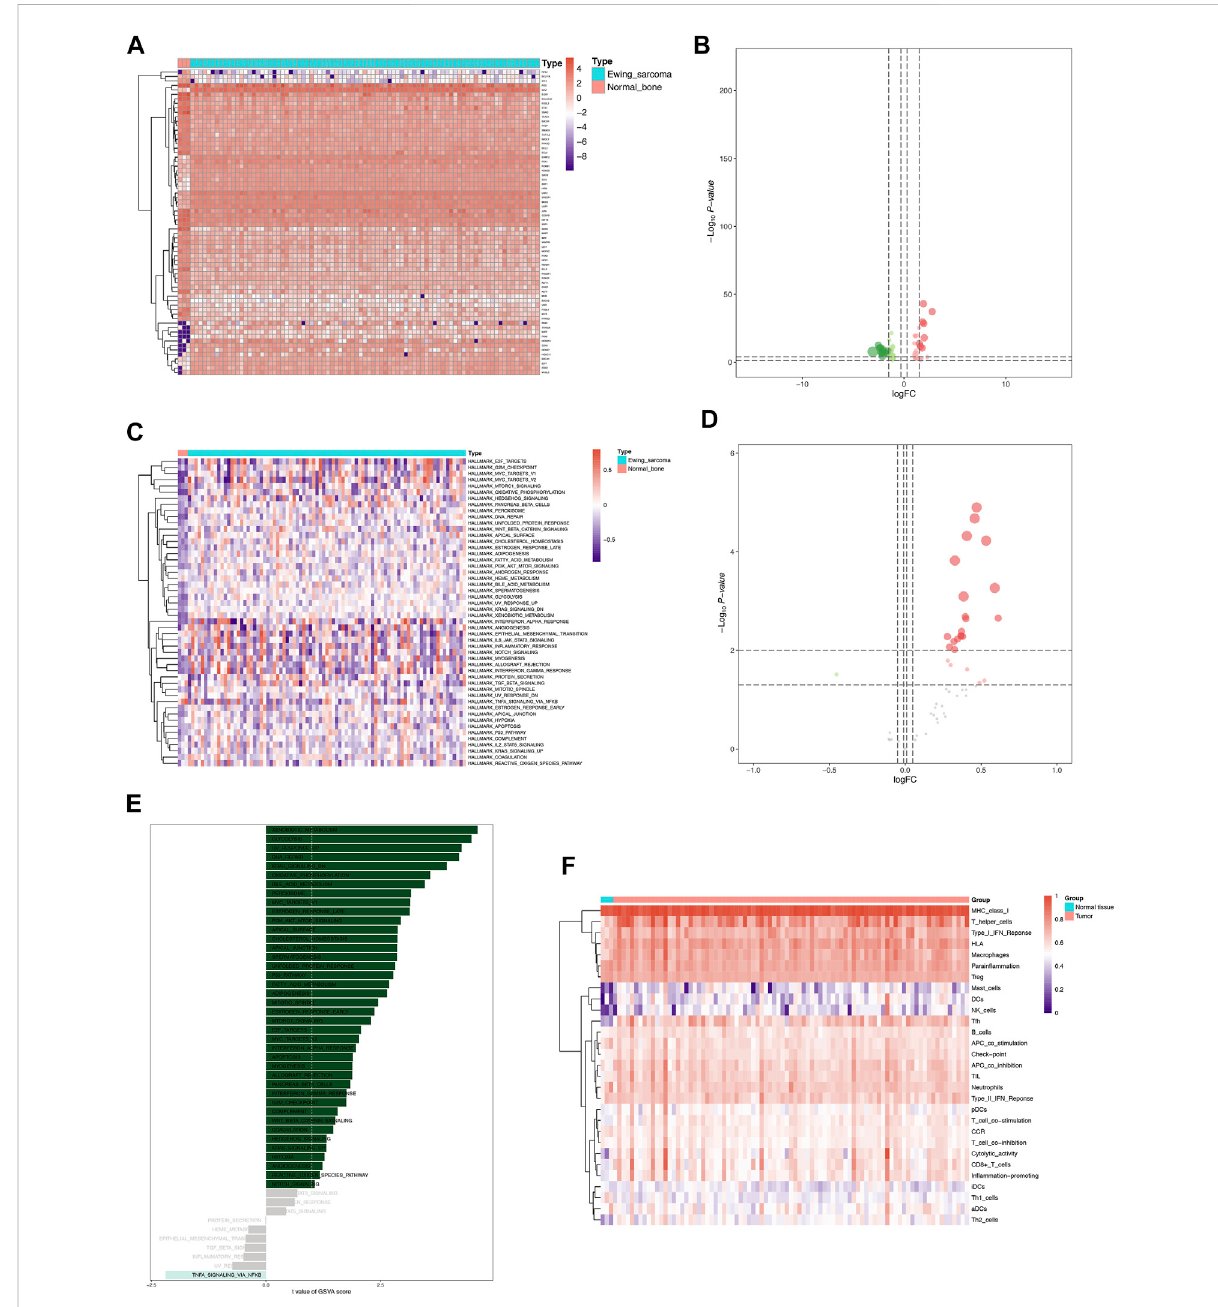
FIGURE 5 Identi fi cation of DETFs, differentially expressed hallmarks of cancer, and immune gene sets co-expressed with DEeRNAs. (A) The heatmap of 68 DETFs in Ewing sarcoma samples and normal bone samples. (B) The volcano plot of DETFs. (C) The heatmap of 21 differentially expressed hallmarks ofcancer identi fi ed between Ewing sarcomasamples and normal bonesamples. (D) The volcano plot ofdifferentially expressedhallmarks of cancer. (E) The correlation of GSVA score of hallmarkpathwaysand Ewing sarcoma. (F) The heatmap of 29 immune-related terms evaluated by ssGSEA between the Ewing sarcoma samples and normal bone